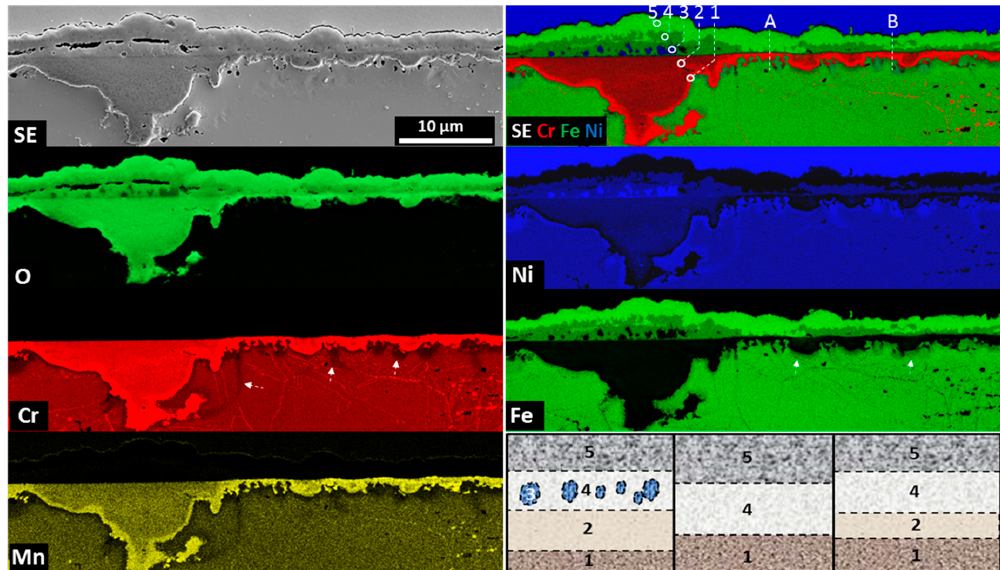
Figure 4. SEM-EDS analysis of the oxide scale after steam oxidation at 700 ◦ C for 500h. ( a ) SE image of the investigated area, ( b ) compositional image of the selected elements, ( c – g ) elemental maps of the selected elements, ( h – j ) schematic drawing of the layers present in the oxide